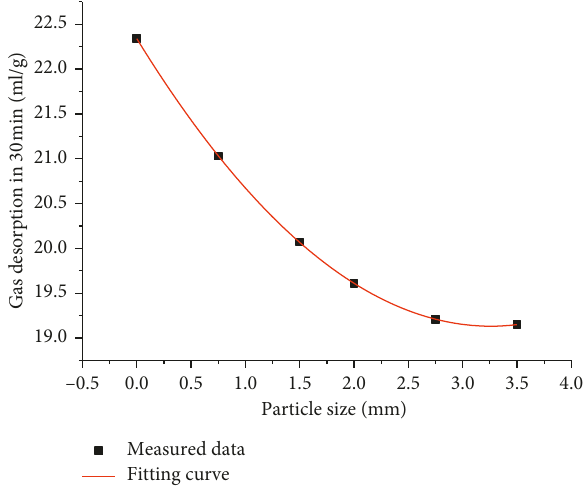
Figure 4: Curve of the gas desorption amount per unit mass in 30min versus the particle